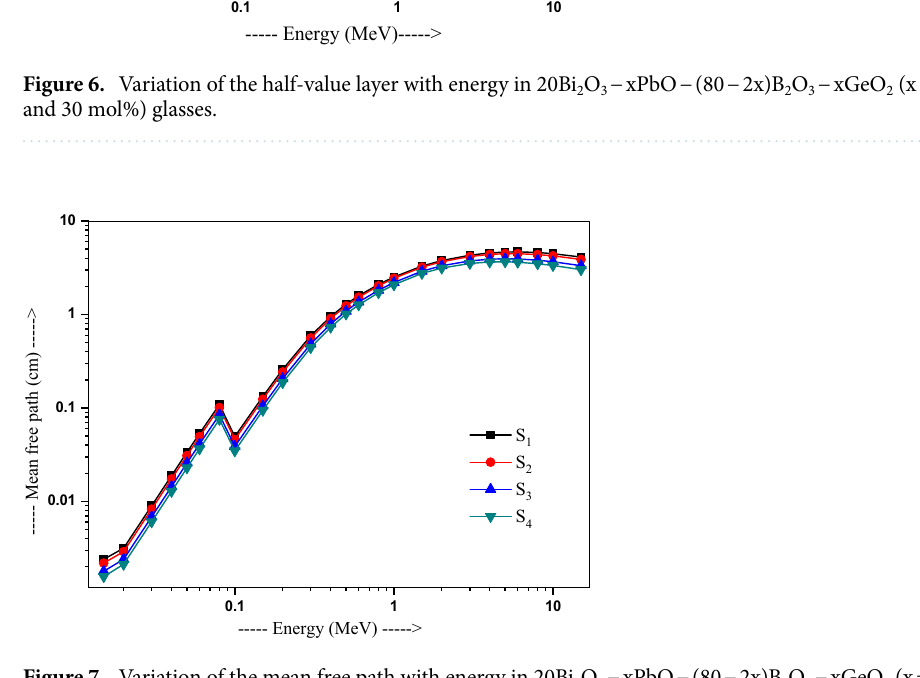
Figure 7. Variation of the mean free path with energy in 20Bi 2 O 3 − xPbO − (80 − 2x)B 2 O 3 − xGeO 2 (x = 5, 10, 20, and 30 mol%)